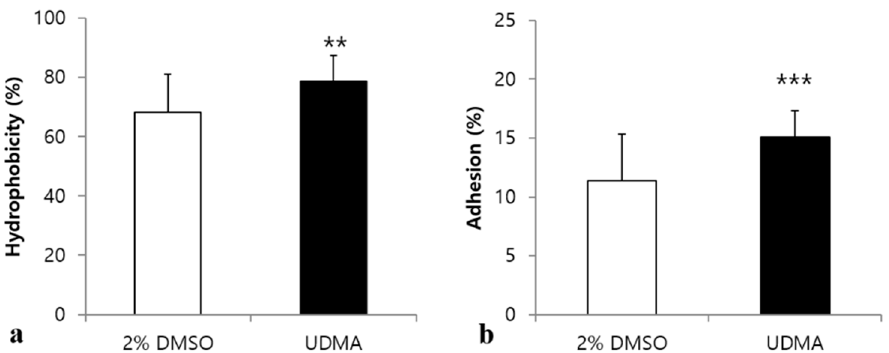
Figure 5. Cell surface hydrophobicity and adhesion of S. mutans UA159 treated with UDMA compared to those of the control. The percentages of cells adhered to the hydrocarbon for 15 min settlement ( a ), and saliva-coated surfaces for 3 h ( b ) were determined. DMSO was used as a vehicle for UDMA, and cells grown in the absence of UDMA (2% DMSO) were used as the control. The data are expressed as mean ± standard deviation values. ** p < 0.01, *** p < 0.001; Mann–Whitney U test.